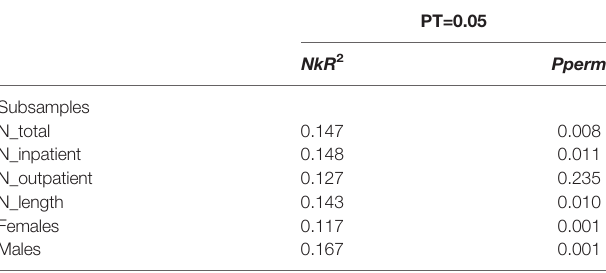
TABLE 4 | Association of GRPS With Subsamples of Cases vs.